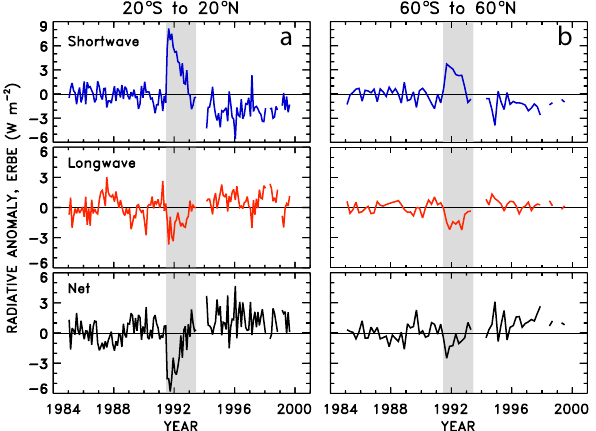
Fig. 15. (a) Deseasonalised times series of shortwave, longwave and net radiation anomalies for 20 ◦ N to 20 ◦ S, from the start of 1985 to end of 1999, with respect to a 1985 to 1989 (pre-Pinatubo) baseline. Data are from ERBE Edition 3 Revision 1, non-scanner, wide field- of-view observations (Wielicki et al., 2002). The gray shaded region denotes the period of time from the eruption of Pinatubo (15 June 1991) until the end of 1992. For this latitude region, raw data are provided as 36-day means. (b) Same as (a) , but for 60 ◦ N to 60 ◦ S. For this latitude region, raw data from the tropics (36-day means) have been combined with raw data from the extra-tropics (72-day means; extra-tropics refer to 20 ◦ to 60 ◦ in both hemisphere) to pro- duce a 72-day mean, near global average (using latitudinal weight-